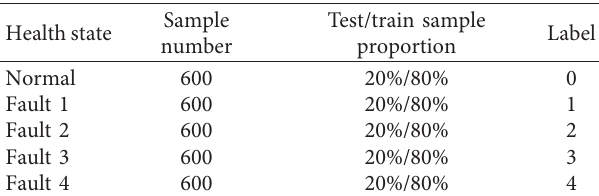
Table 2: Data description of